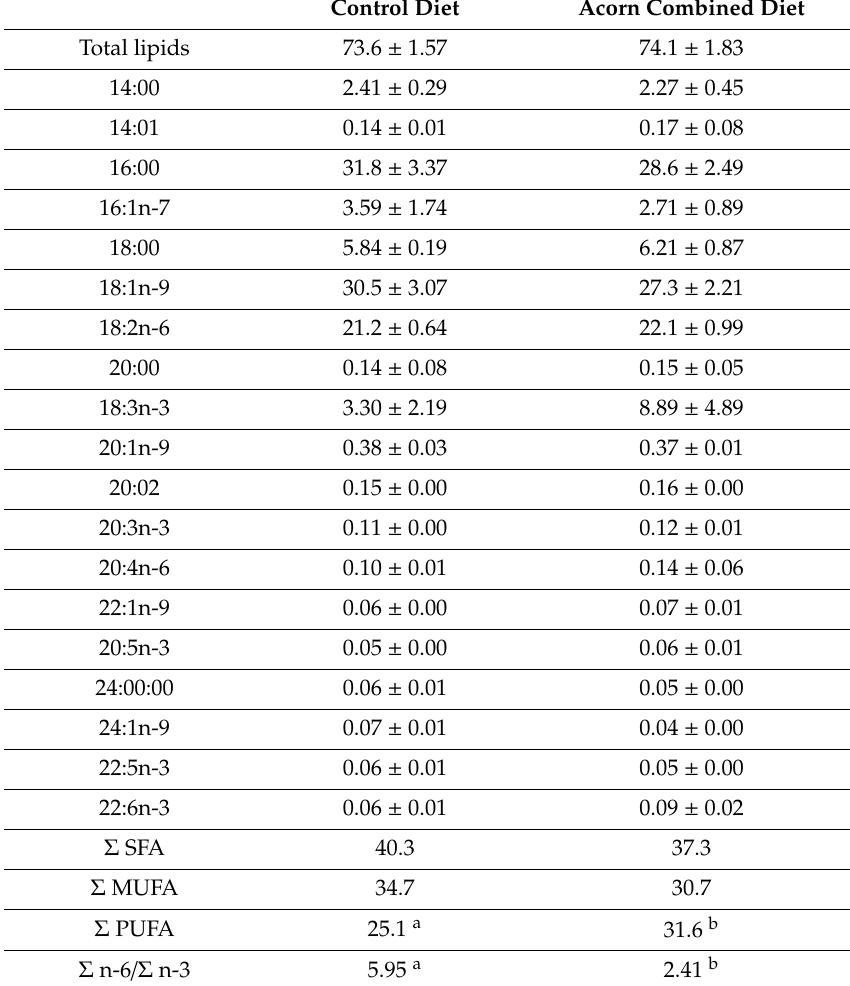
Table 4. Total lipid content and fatty acids composition of perirenal fat of rabbits fed with the two experimental diets (total lipids: g / kg; fatty acid composition: mg / kg fatty acids; mean ± SD). Control Diet Acorn Combined